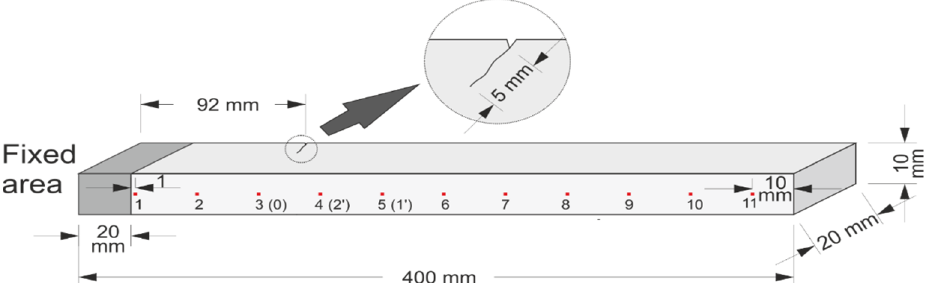
Figure 16. Fatigued steel cantilever beam draft.